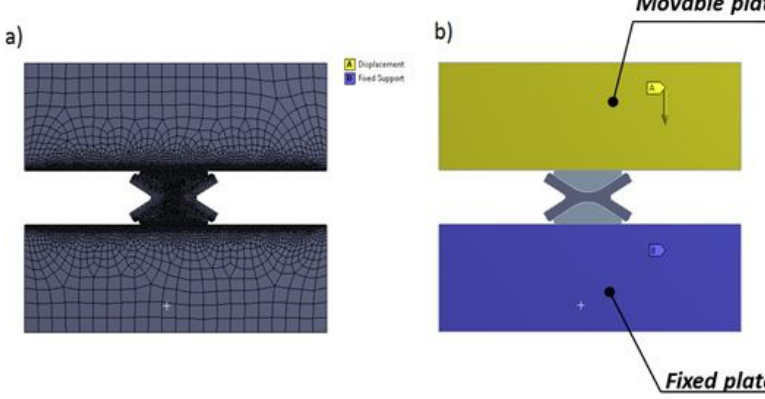
Figure 6: The numerical model of the gasket’s compression: a) discretization of particular areas, b) boundary conditions